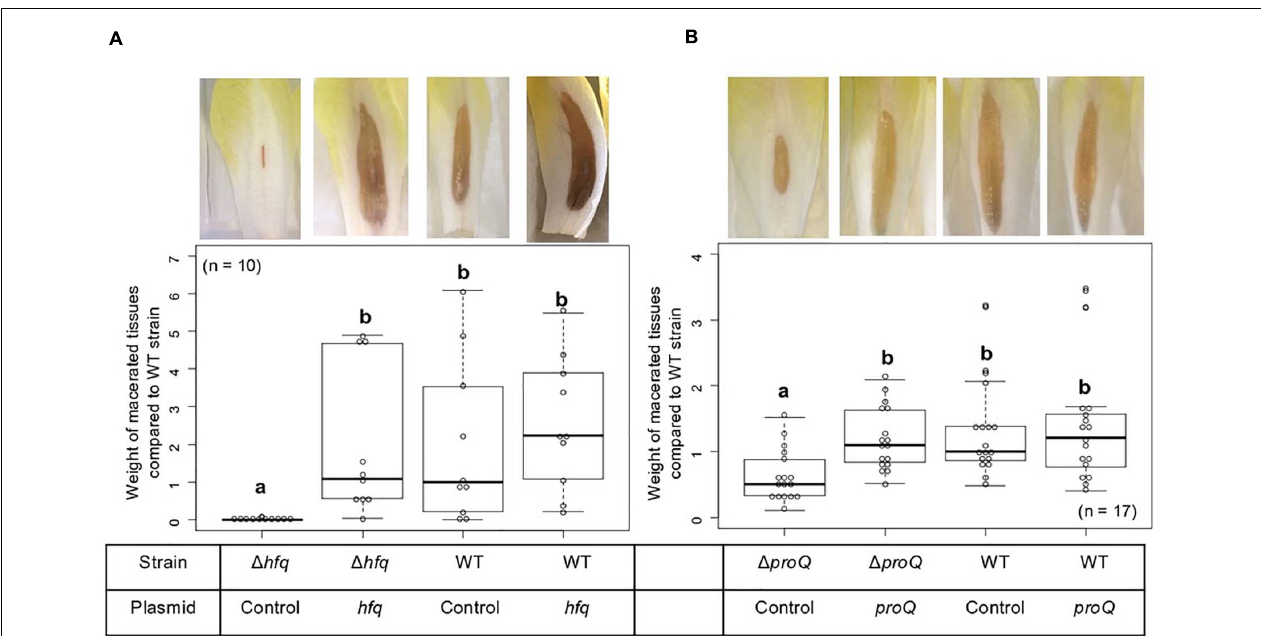
FIGURE 2 | Impact of Hfq and ProQ on D. dadantii virulence. Representative examples of symptoms induced by the wild type and mutant strains and weights of macerated tissues following infection by the hfq (A) and proQ mutants (B) , the wild type strain and the respective complemented strains. Data were normalized based on the weights of macerated tissues from the wild-type strain. Chicory leaf assays were performed as described in the Materials and methods section with an incubation time of 18 h, and weights of macerated tissues were measured. The experiments were repeated three times with ten leaves tested in each replicate. Non-capital letters a and b are presented above the boxplots. Groups with the same letter are not detectably different (are in the same set) and groups that are detectably different get different letters (different sets). Note that if the groups have the same letter, this does not mean they are the same, just that there is no evidence of a difference for that pair ( P < 0.05, Wilcoxon Mann-Whitney